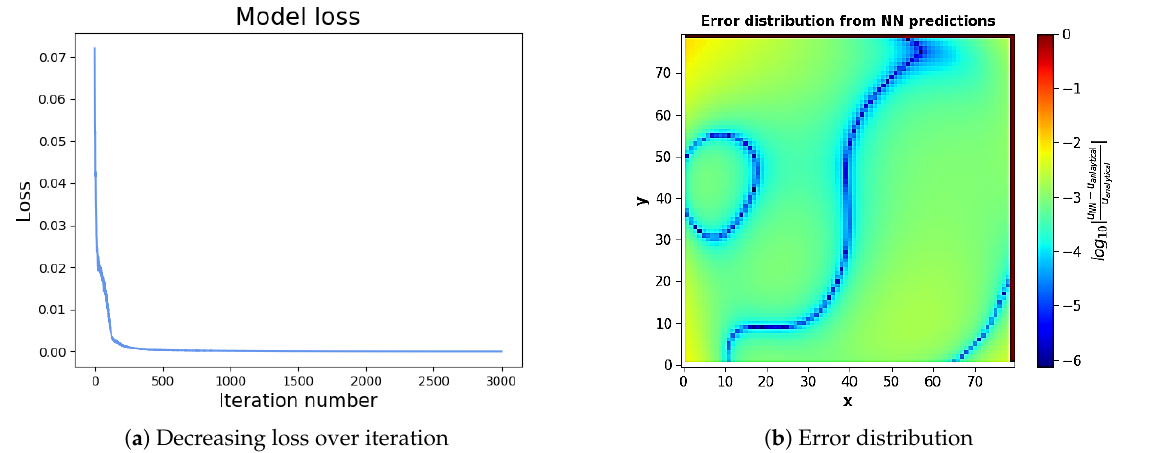
Figure 12. The loss history ( a ) and error contour ( b ) of neural network predictions for Poisson equation.